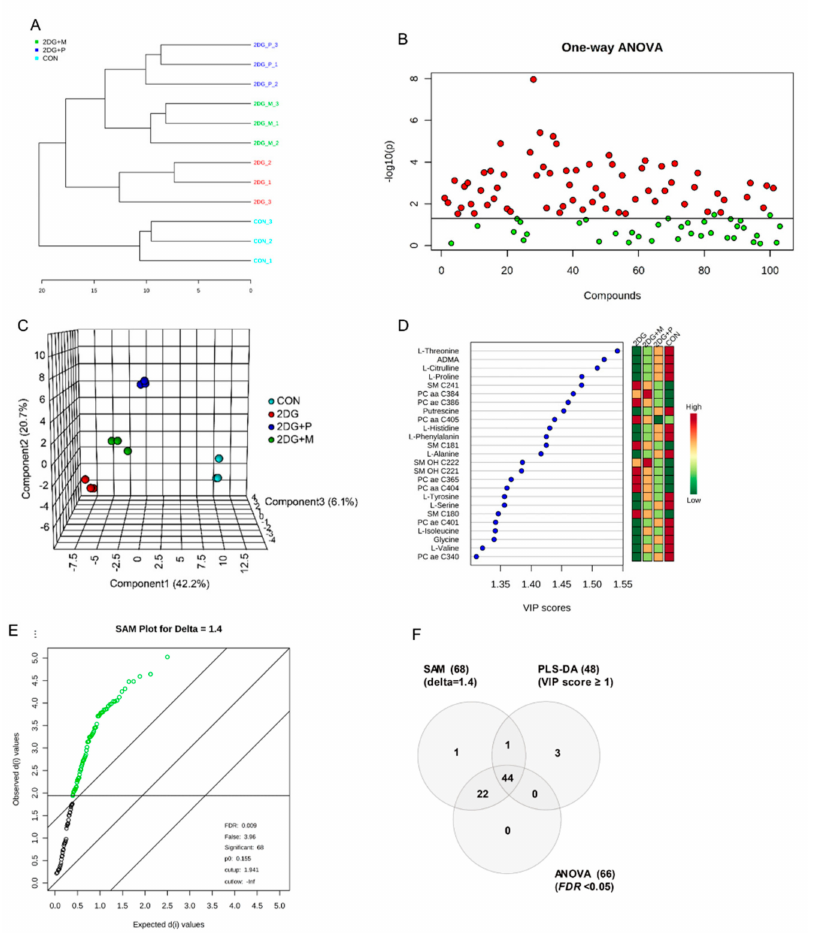
Figure 4. Statistical analysis for the identification of the altered metabolites in SCC15 cells. ( A )Dendrogramofunsupervisedhierarchicalclusteringforpotentialmetabolites(distancemeasurement using Pearson’s correlation, and clustering algorithm using Ward. D). ( B ) ANOVA plot showing the important metabolites by one-way ANOVA and posthoc analysis (q value < 0.05, Tukey’s HSD) ( C ) 3D-Partial least squares-discriminant analysis (PLS-DA) scores scatter plot showing spatial division among all the four groups, R2X = 0.91, R2Y = 0.97, Q2X = 0.82, Q2Y = 0.92. ( D ) Key metabolites based on variable importance in projection (VIP) score plot in PLS-DA analysis. ( E ) Significant metabolites identified by SAM plot (Delta score = 1.4, green circles represent the significant metabolites). ( F ) Venn diagram showing the numbers of significantly altered metabolites identified using PLS-DA, ANOVA, and SAM